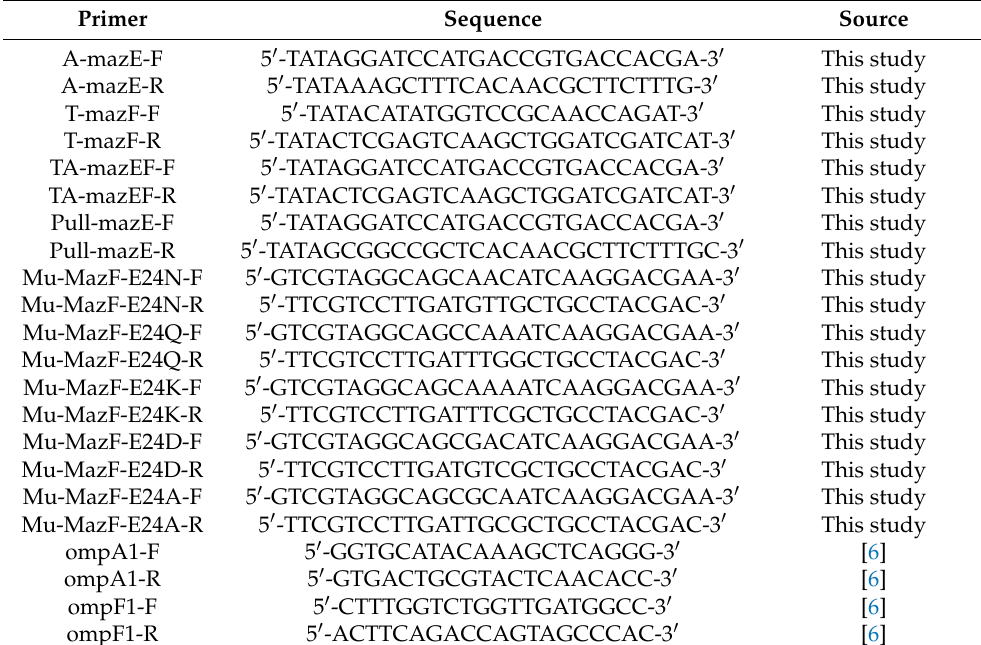
Table 2. Primers used in this